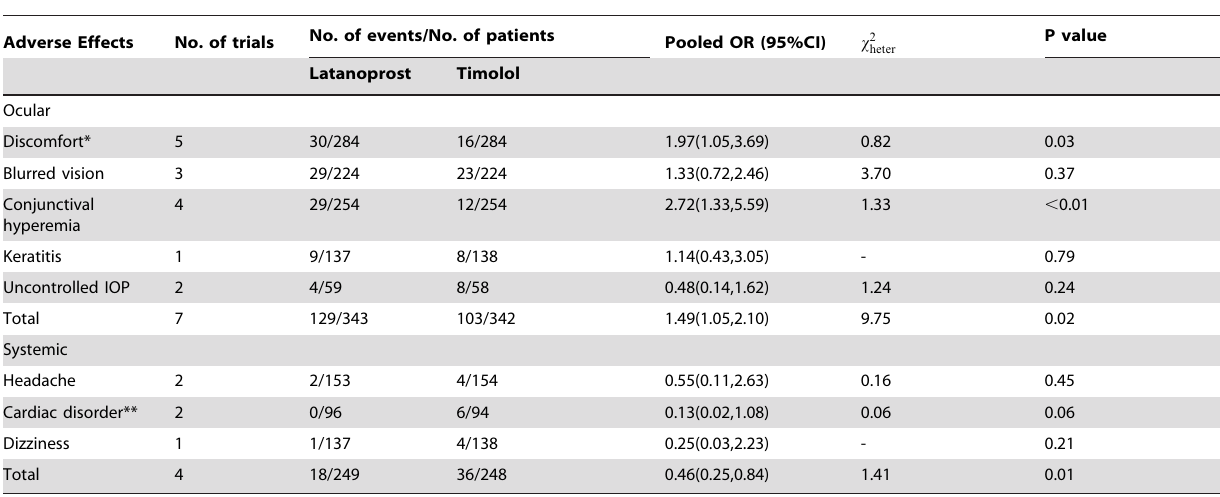
Table 4. Risk of adverse effects with latanoprost and